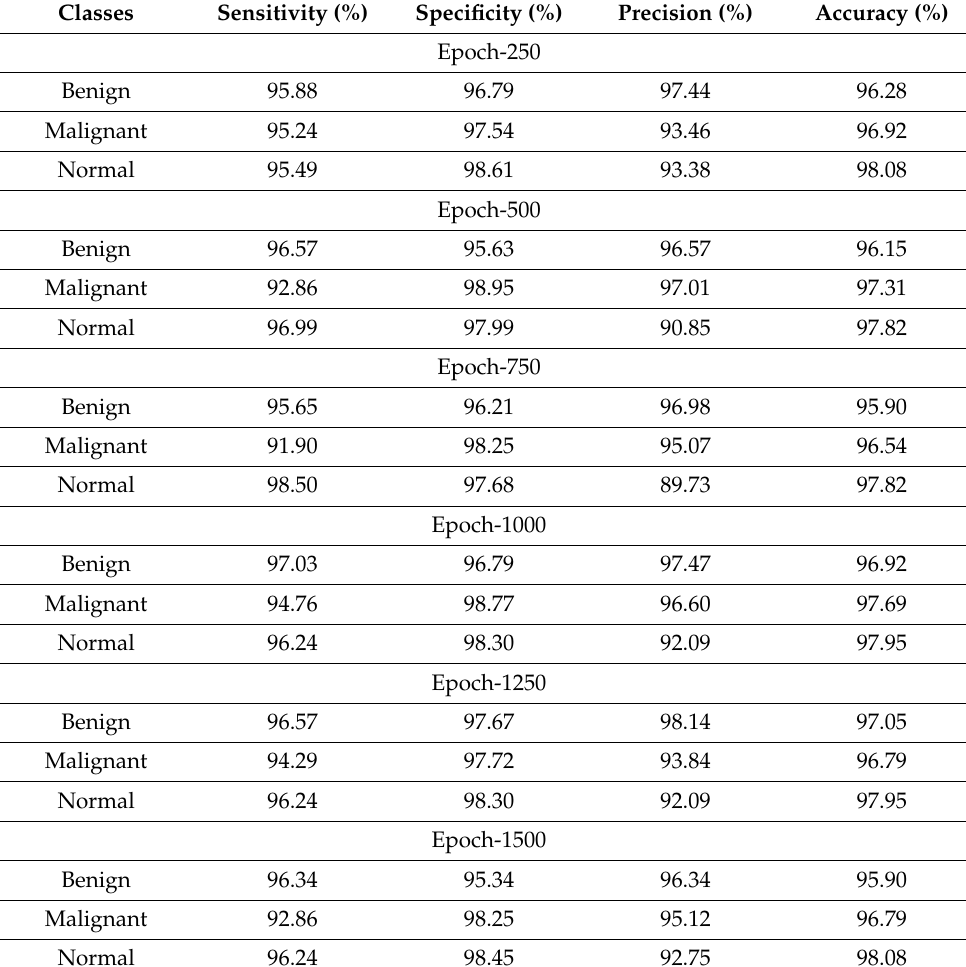
Table 1. Analysis results of EDLCDS-BCDC technique with distinct